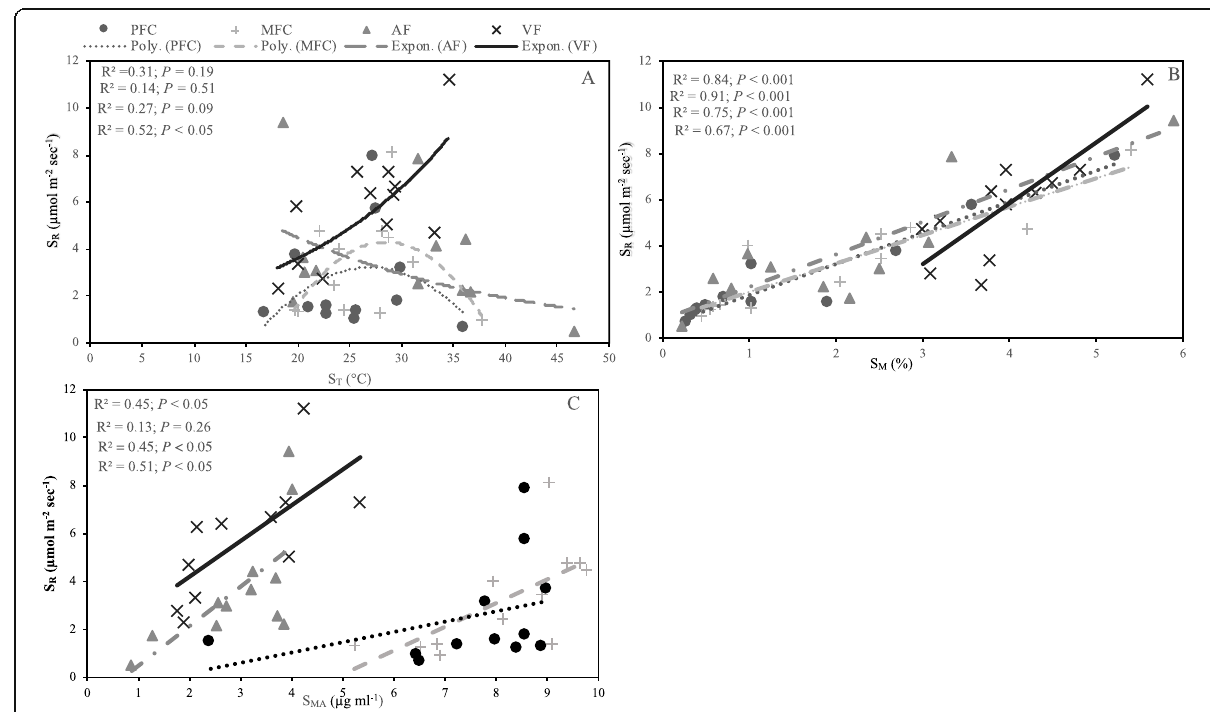
Fig. 5 Relationship between S R soil respiration and environmental factors among four land uses. S T Soil temperature (at 10 cm depth) ( a ), S M soil moisture ( b ), and S MA soil microbial activity ( c ) (showing the best fit) of PFC Prosopis juliflora forest cover, MFC mixed forest cover, AF